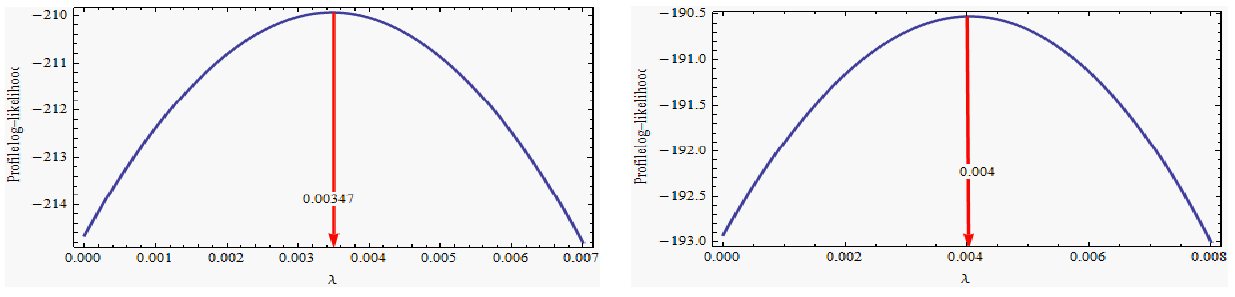
Fig. 2. Pro(cid:133)le log-likelihood function of the shape parameter (cid:21): Figure 2. Profile log-likelihood function of the shape parameter λ